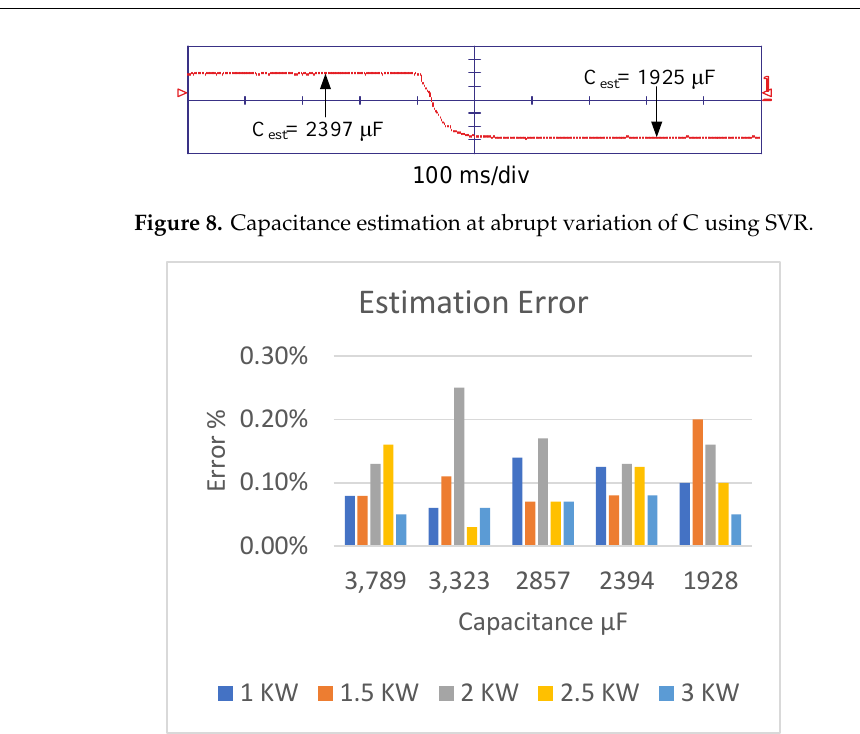
Figure 7. Capacitance estimation at abrupt variation of C using particle swarm optimization-based support vector regression (PSO-SVR). Figure 8. Capacitance estimation at abrupt variation of C using SVR.